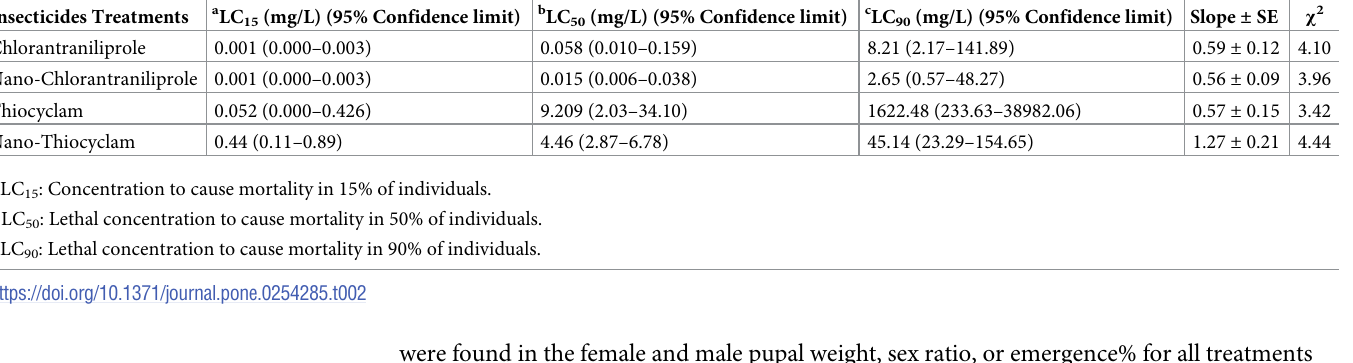
were found in the female and male pupal weight, sex ratio, or emergence% for all treatments (Table 3). Fecundity and fertility Chlorantraniliprole, thiocyclam, and their nano-forms significantly decreased the hatchability percent under LC and LC compared to the control (Table 4). After chlorantraniliprole and 15 50 nano-chlorantraniliprole treatment, the hatchability percentages were 84.60, and 81.29% at LC , and 73.83, and 73.08% at LC respectively. Under thiocyclam and nano-thiocyclam 15 50, treatment, the hatchability percentages were 82.64, and 78.32% at LC , and 78.79, and 71.99% 15 at LC . In contrast, the number of eggs laid by one female showed no significant differences 50 between treated and untreated larvae (Table 4). Activity of oxidative stress enzymes Exposure to both insecticides and their nano-forms caused a significant increase in SOD activ- ity after treatment with the LC of thiocyclam (40.09 U/g of protein) and nano-thiocyclam 50